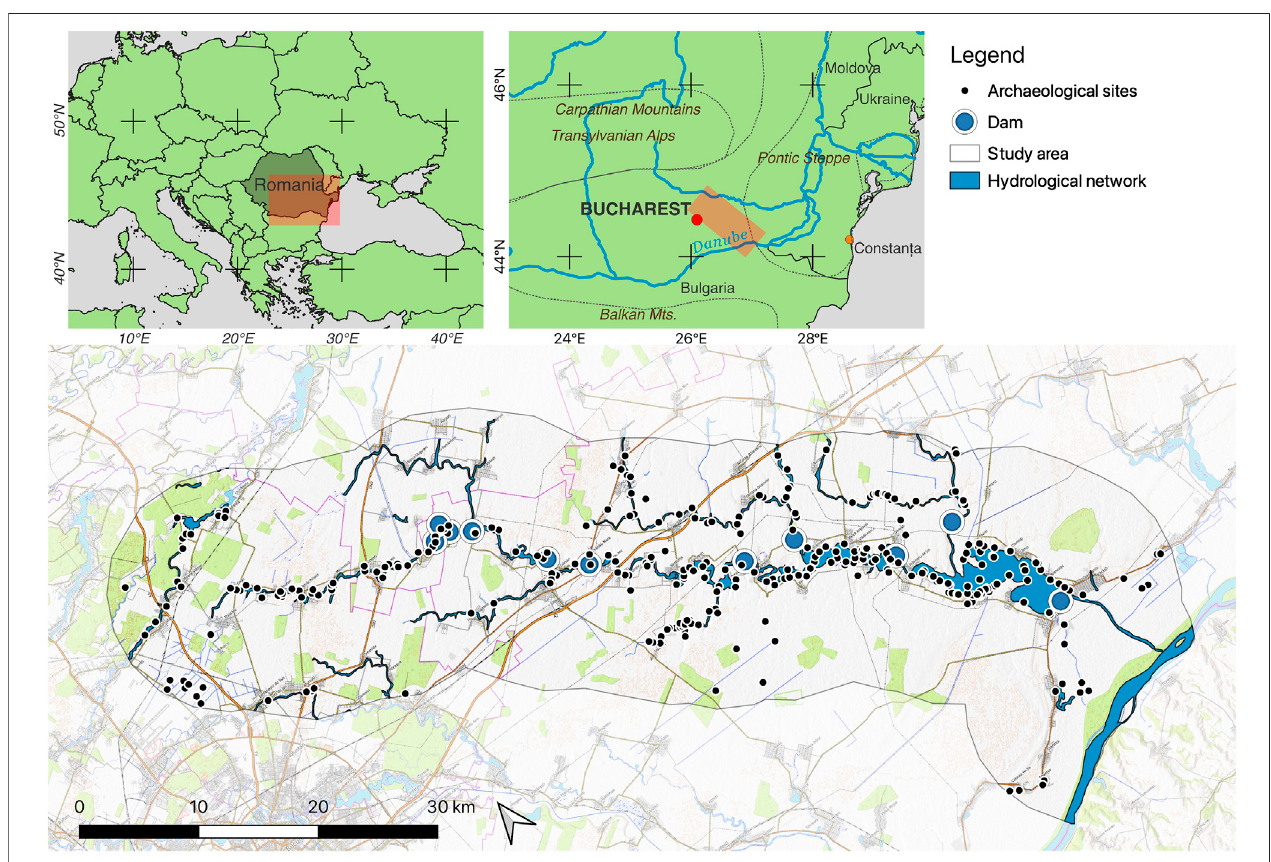
FIGURE 1 | Study area and site distribution on Mosti ș tea Valley, SE Romania.